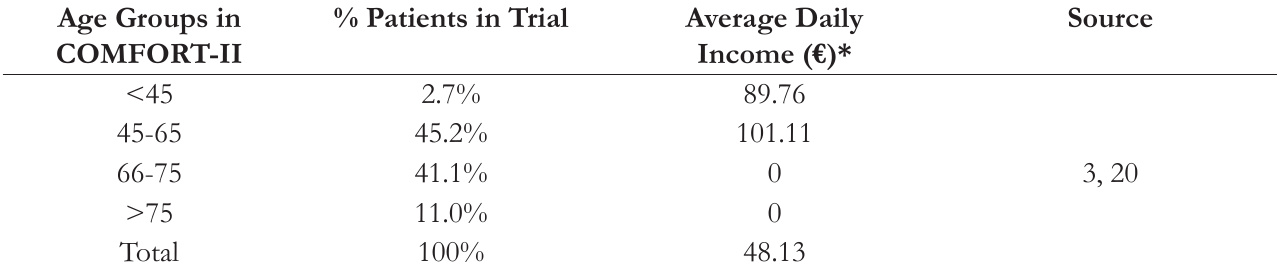
Table 4. Average Annual Income in the Study Cohort Age Groups